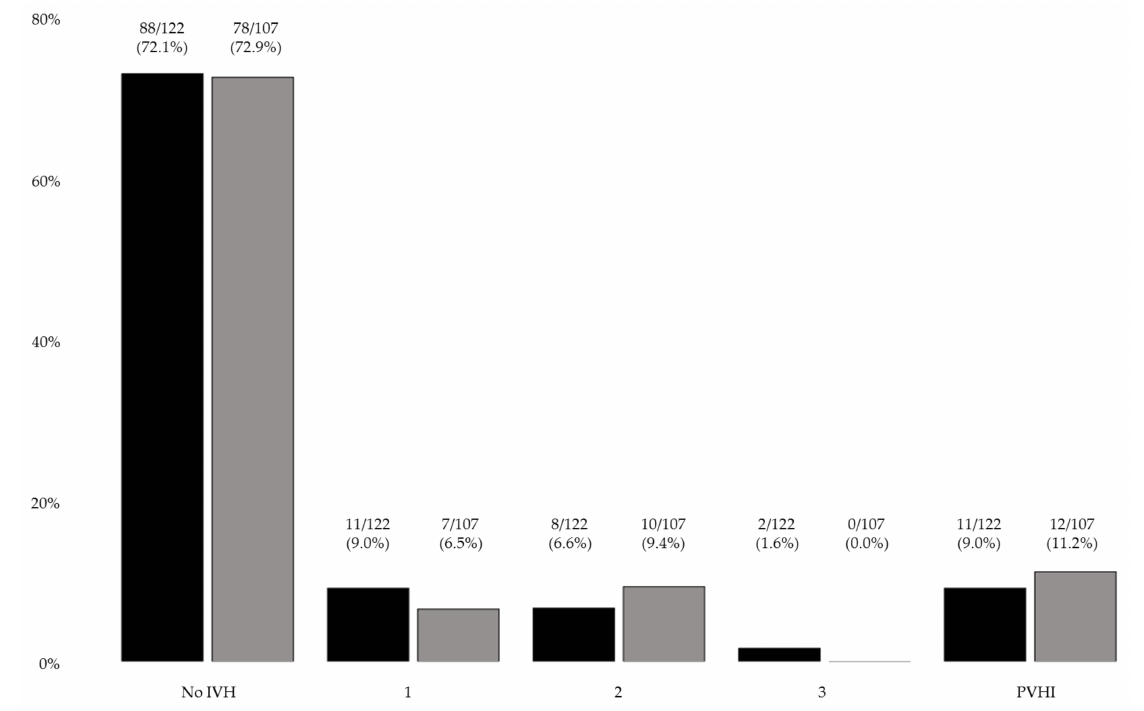
Figure 1. Number and percentage of IVH grades of severity; before (black) vs. after (grey) implementation of the neonatal